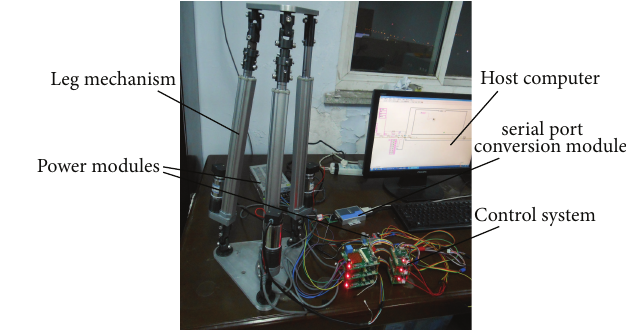
Figure 8: Hardware system of the leg